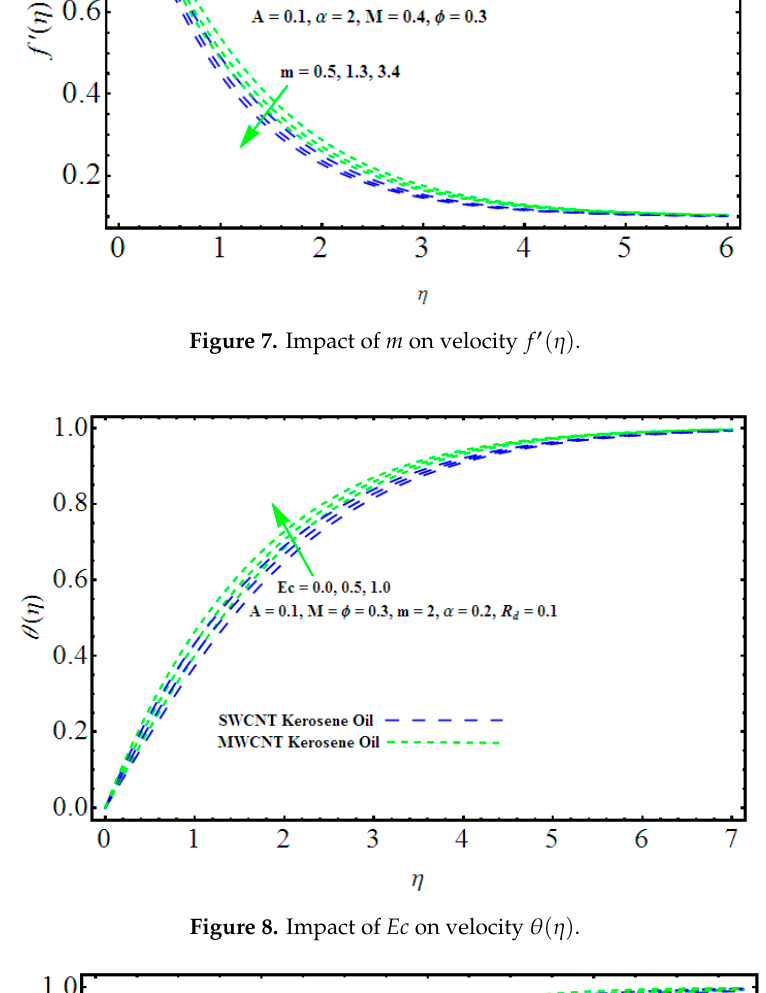
Figure 8. Impact of 𝐸𝑐 on velocity 𝜃(𝜂) .